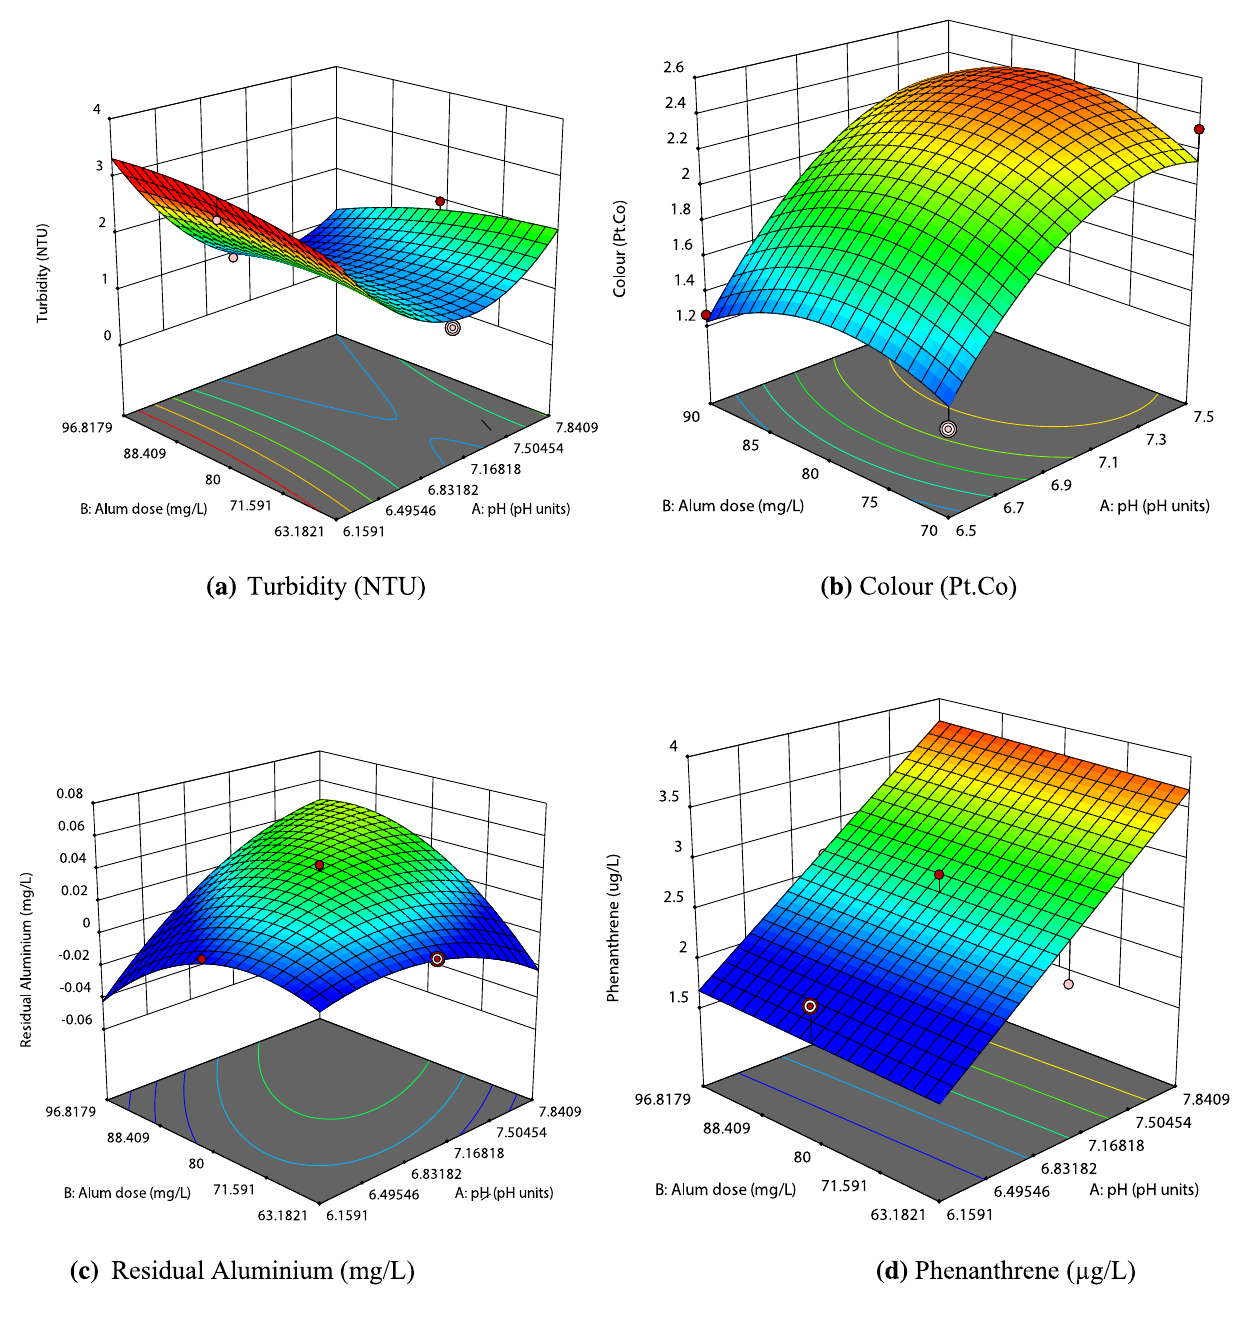
Fig. 3 Response surface plot for interaction and optimum points on contaminant removal for coagulation